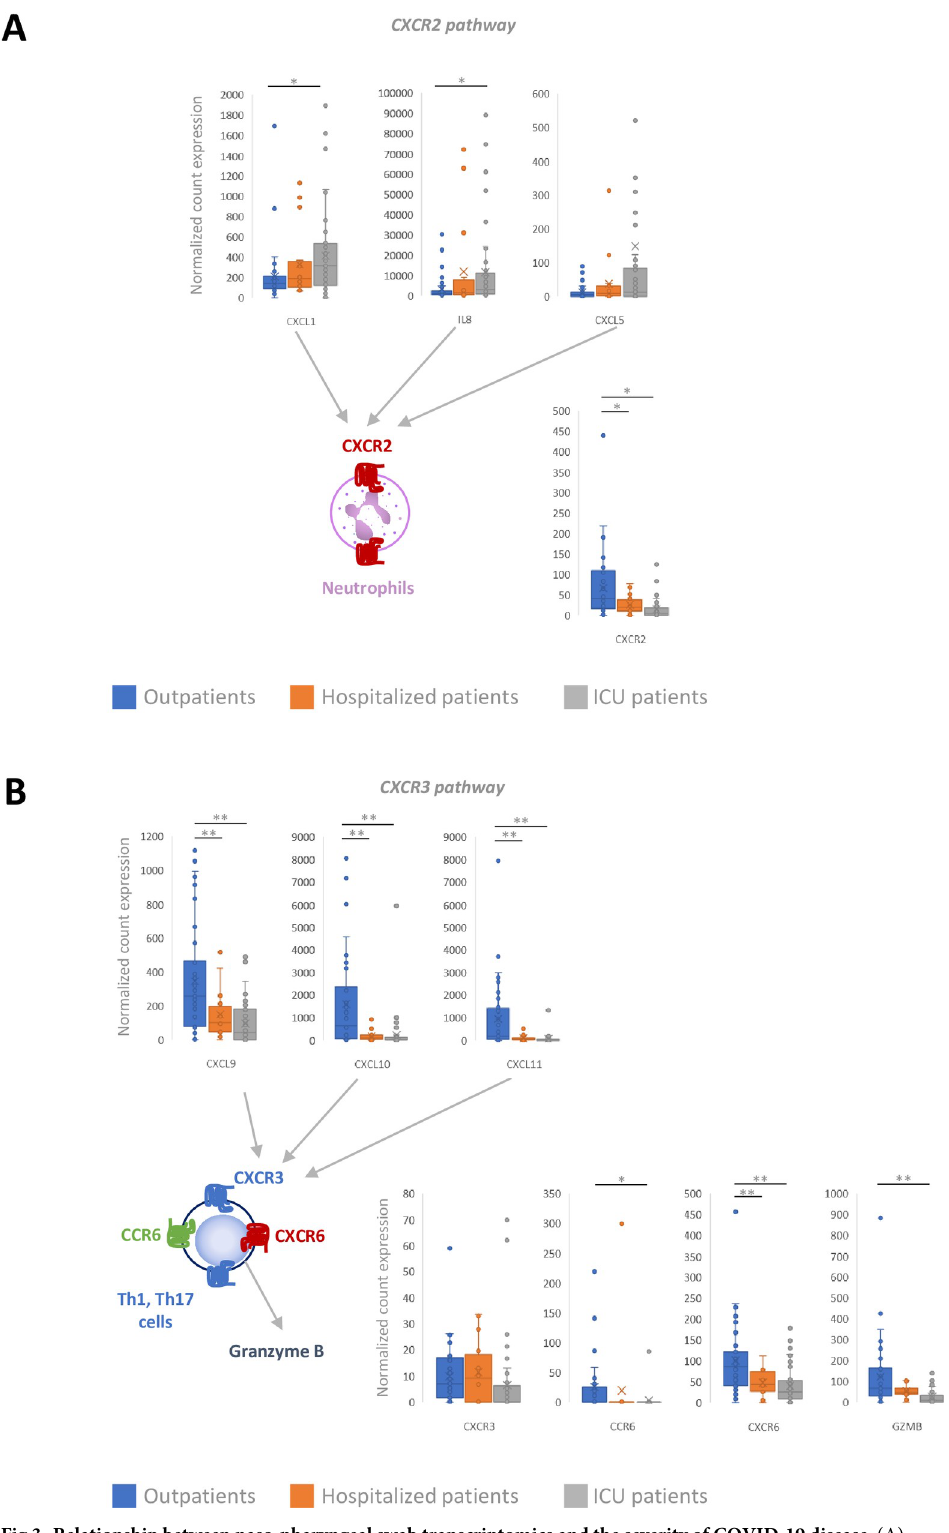
Fig 3. Relationship between naso-pharyngeal swab transcriptomics and the severity of COVID-19 disease. (A) CXCR2 receptor pathway. (B) CXCR3/CCR6 pathway. � p < 0.05; �� p < 0.01.